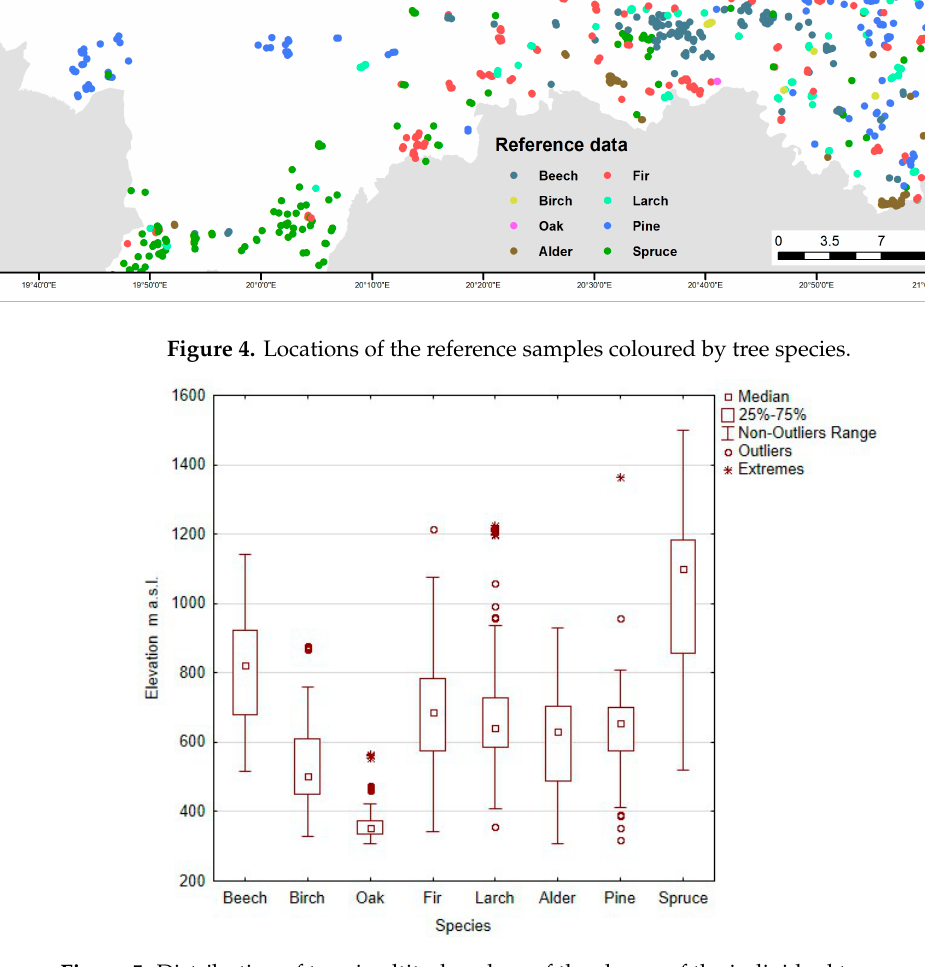
Figure 5. Distribution of terrain altitude values of the classes of the individual tree species.